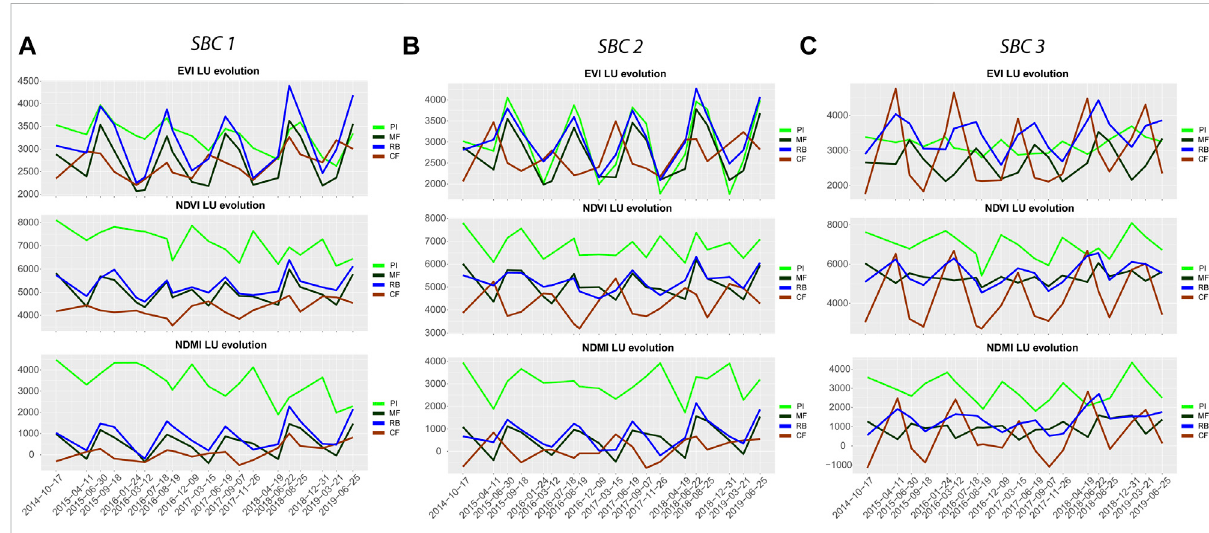
FIGURE 4 Enhanced vegetation index (EVI), normalized difference vegetation index (NDVI), normalized difference moisture index (NDMI), soil-adjusted vegetationindex(SAVI),andmodi fi edsoil-adjustedvegetationindex(MSAVI)meanvaluesfromLandsat8-OLIforthe19samplingcampaignsdivided bythethree studied sub-catchments( (A) -SBC1, (B) -SBC2, and (C) -SBC3) and for thedifferent landuses, agricultural (AG), Mediterranean forest (MF), pine afforestation (PI), and riverbank vegetation